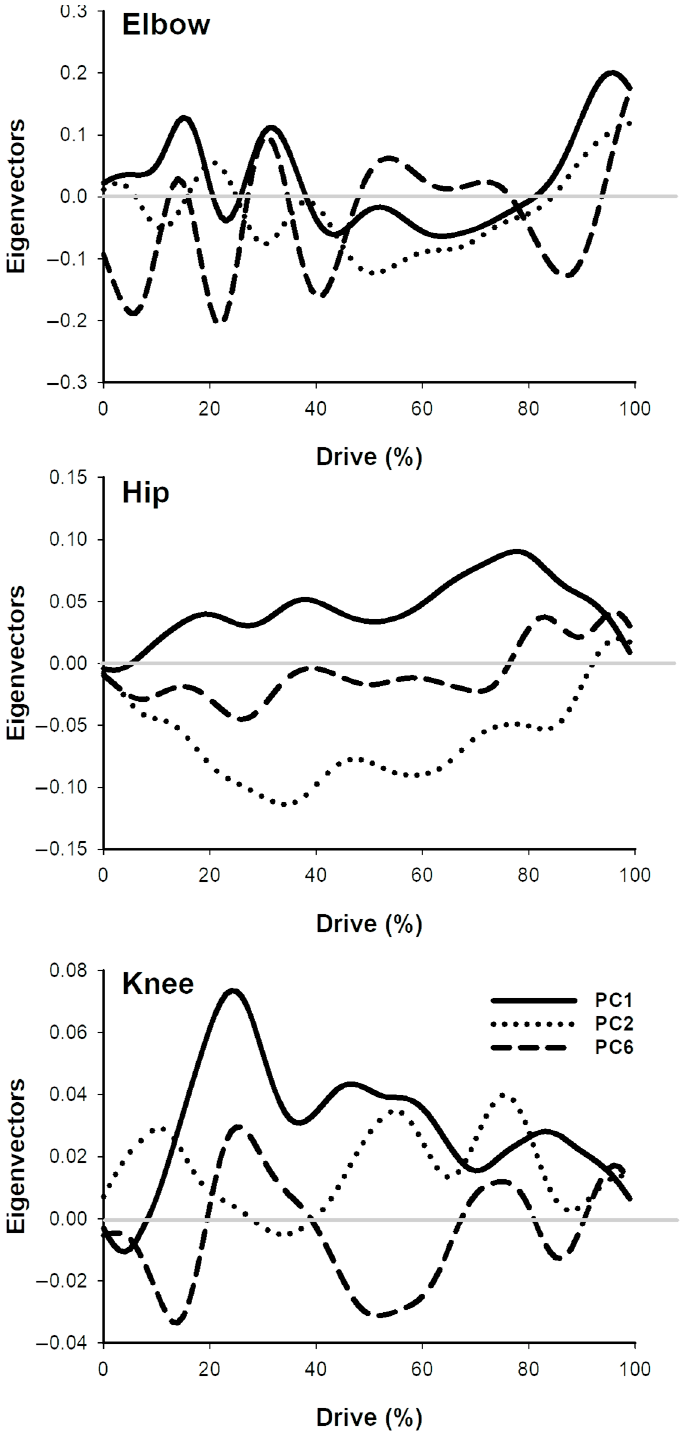
Figure 5. Eigenvectors representative of PC1, PC2, and PC6 for the elbow, hip and knee.